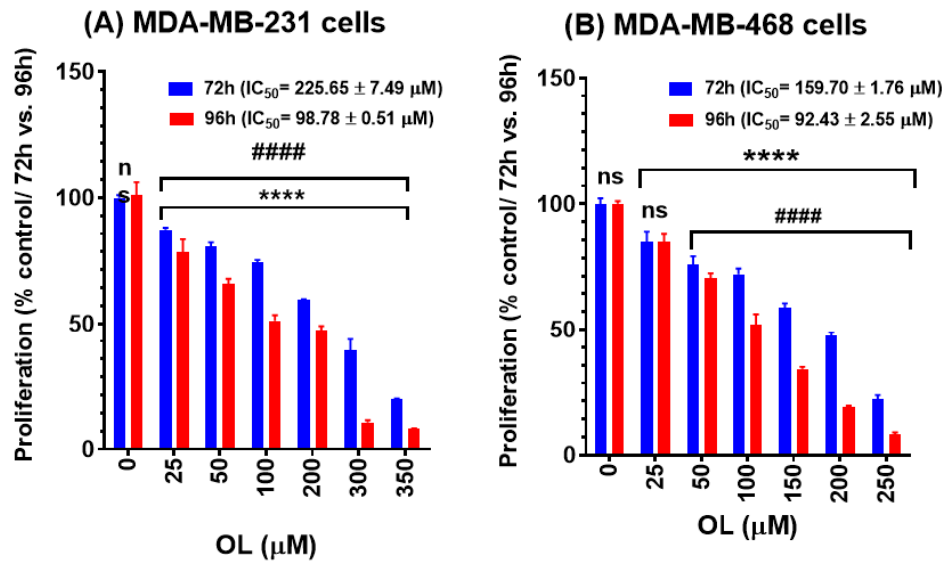
Figure 2. Antiproliferative effect of oleuropein (OL) in ( A ) MDA-MB-231 and ( B ) MDA-MB-468 TNBC cell lines. Both cell lines were seeded in 96-well plates at 1 × 10 4 cells/100-µL/well and incubated